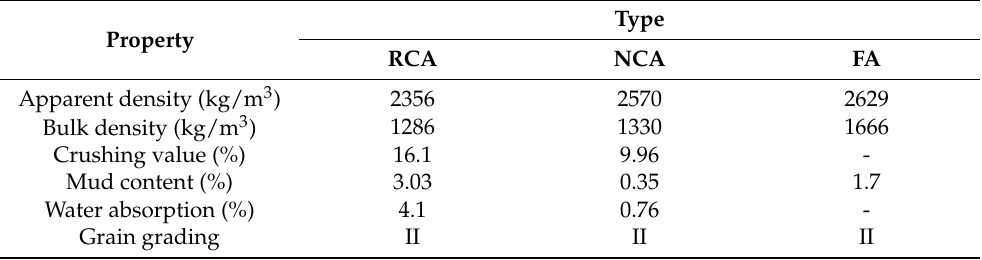
Table 2. The basic properties of RCA, NCA and FA.